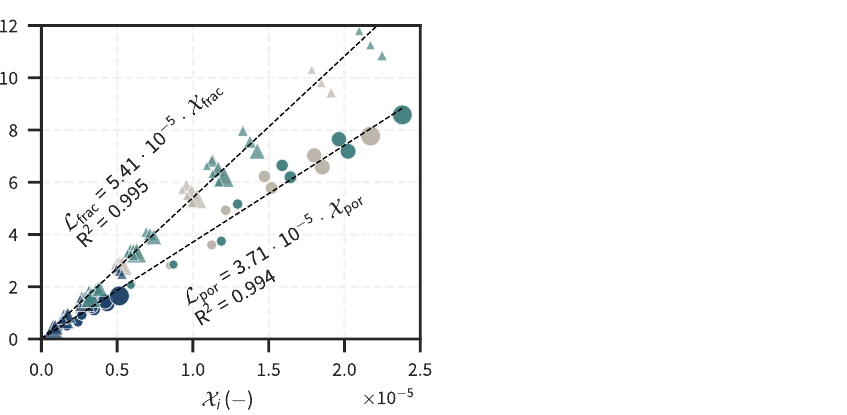
Figure 7. ( a ) The porous layers show clear signs of being transport-limited with respect to loss due to scaling, whereas the fracture layers are rather reaction-limited. ( b ) Initial ion ratios for the considered samples versus the precipitation potential ( N eq ), i.e., the maximum amount of barite that can precipitate, provided thermodynamic equilibrium is reached, show a positive correlation. ( c ) The final layer permeability loss can be fitted with an analytical scaling score (Equation (19)). The upper dashed line for the fracture layers is a linear regression using an exponent a = 1.9. The lower dashed line is for the porous layers and uses an exponent of a =